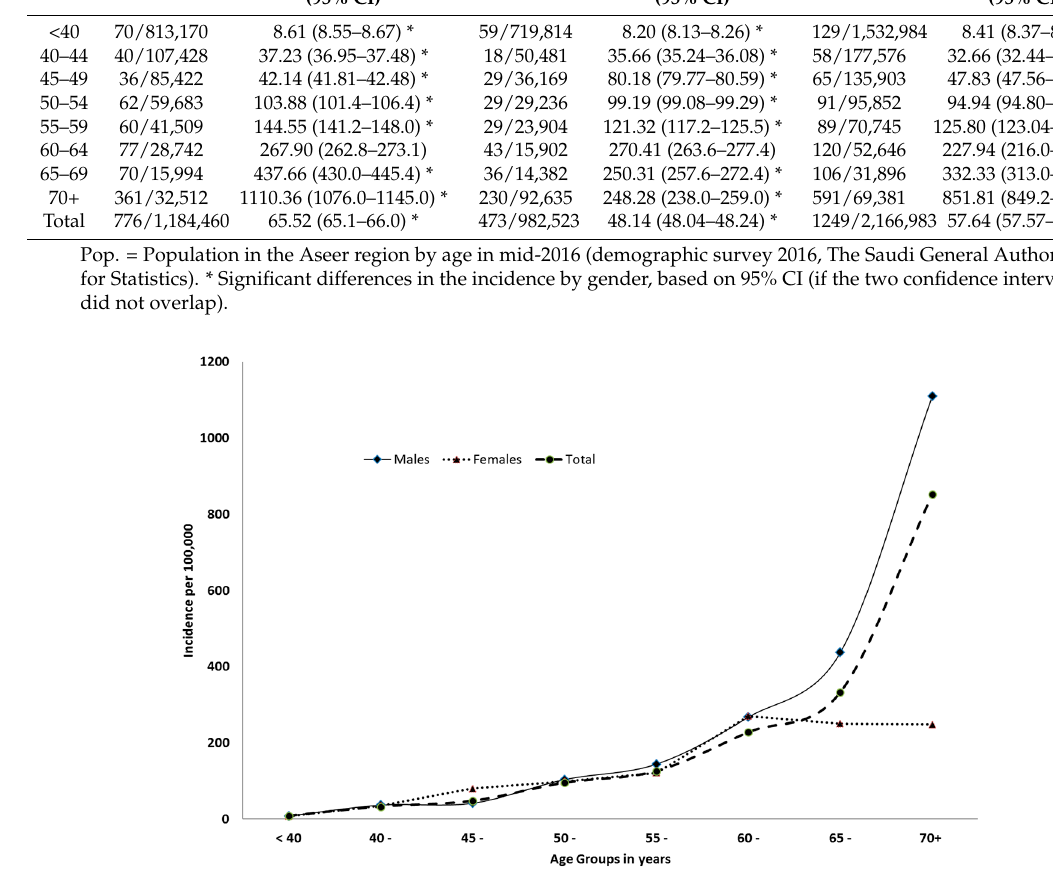
Figure 1. Minimal incidence rate of hospitalized first-time stroke (per 100,000 people) by sex and age groups.